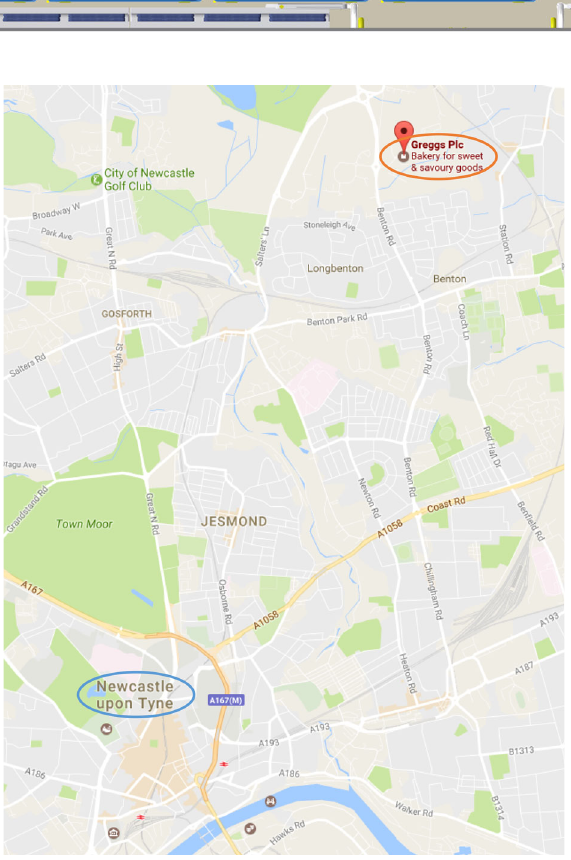
Fig. 23 Map showing location of Greggs